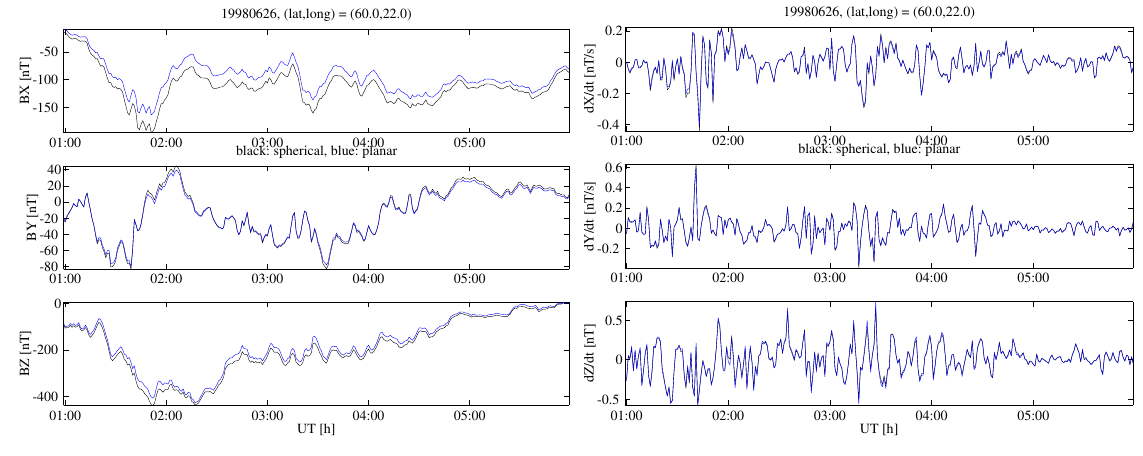
Fig. 2. Comparison of the ground magnetic field and its time derivative calculated in a spherical (black line) and planar geometry (blue line). The ionospheric equivalent current system used as input for both cases was determined in the spherical geometry. The effect of the conducting Earth is ignored.